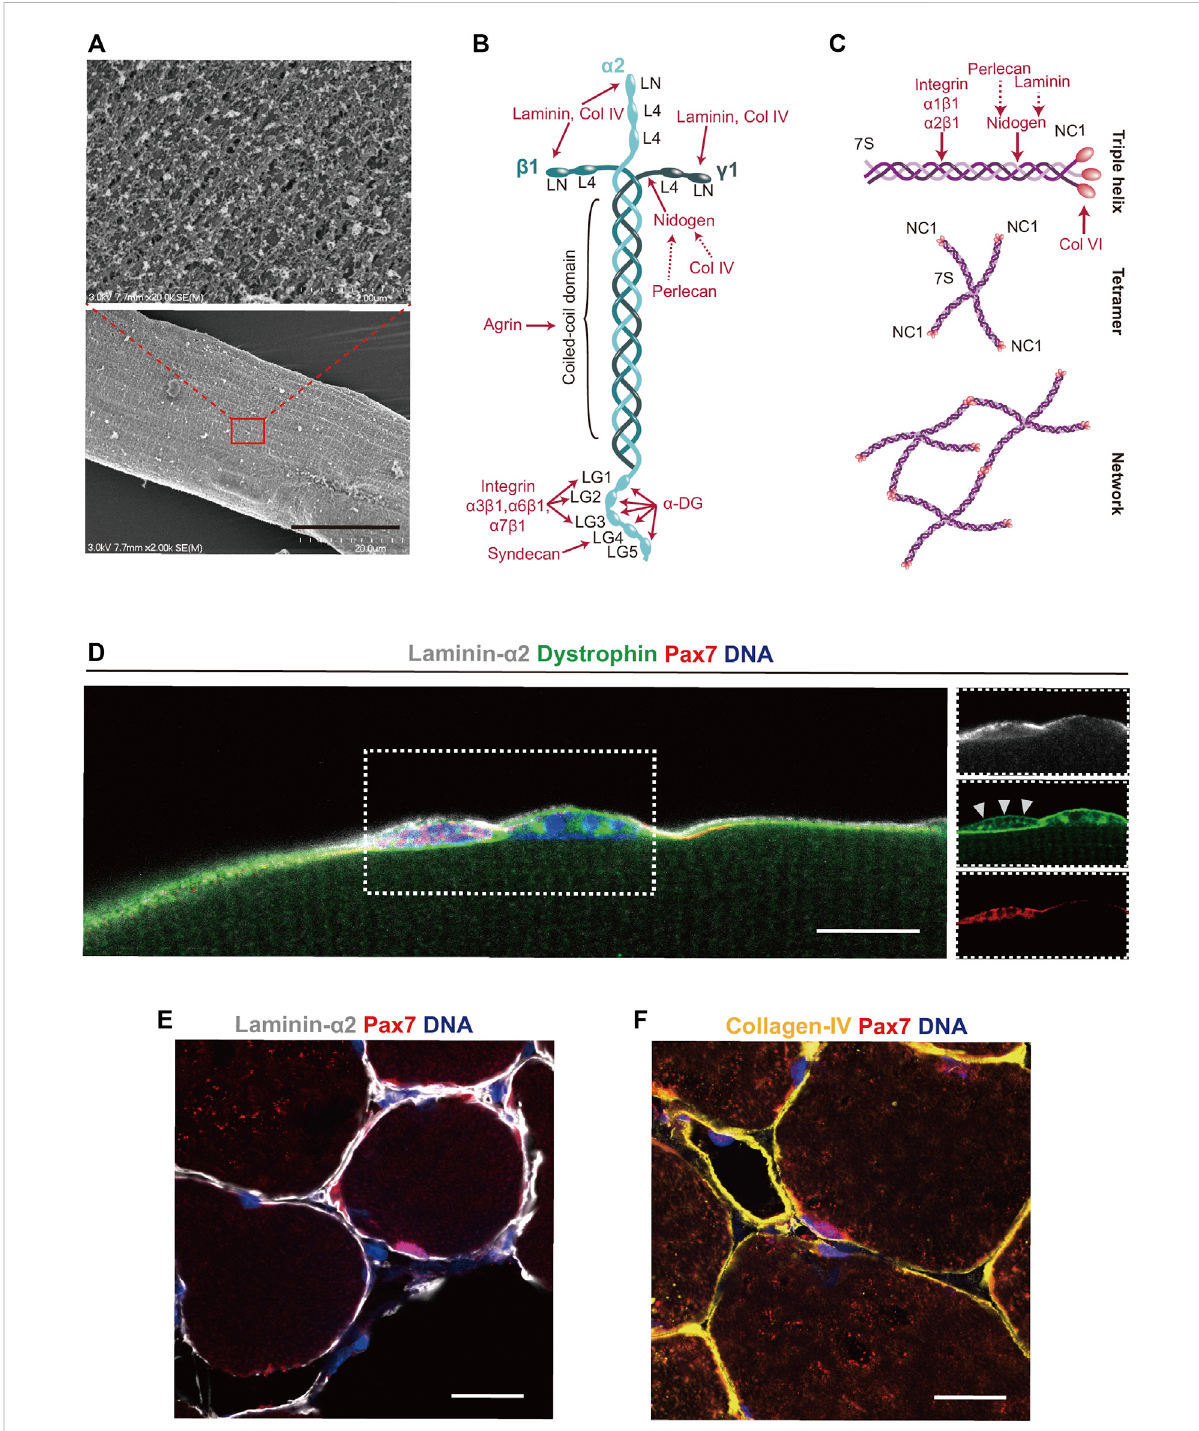
Laminin 211 and collagen IV in thebasal lamina. (A) Scanning electron microscopy image ofa single mouse muscle fi ber that was isolated using collagenase type I, which cleaves collagen I, II, and III. The insert shows a higher magni fi cation of the muscle fi ber basal lamina as well as residues of interstitial ECM components. (B,C) Schemes showing the structure of laminin 211 and the assembly of the collagen IV network in the basal lamina. Interaction sites of ECM proteins and receptors are shown in red. (D) Immunostaining showing a single Pax7 positive MuSC (red) covered by laminin α 2 (white) in the basal lamina, co-stained with the inner membrane marker dystrophin (green) and DNA (blue) on a manually teased mouse muscle fi ber bundle. Dystrophin is expressedby both the muscle fi ber and MuSCs, albeit levels are lower inquiescent MuSCs (whitearrowheads). (E) Immunostaining of mouse skeletal muscle cross sections showing laminin α 2 (white), (E) , collagen IV (yellow), (F) , Pax7 (red) and DNA (blue). Scale bars = 20 µm (Lower image A,D-F), and 2 µm (High magni fi cation insert in